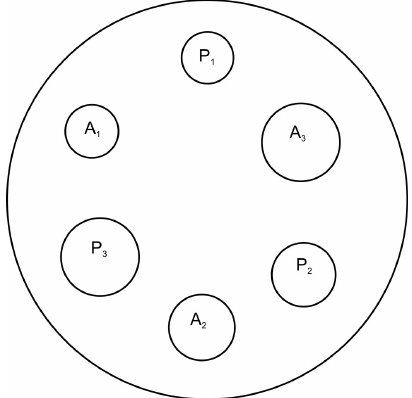
FIGURE 2 - Delineation 3 x 3, demonstrating the standard solutions (P) and sample solutions (A) disposed in Petri dishes, where P (50.0 µg/mL); P (100.0 µg/mL); P (200.0 µg/mL) 1 2 3